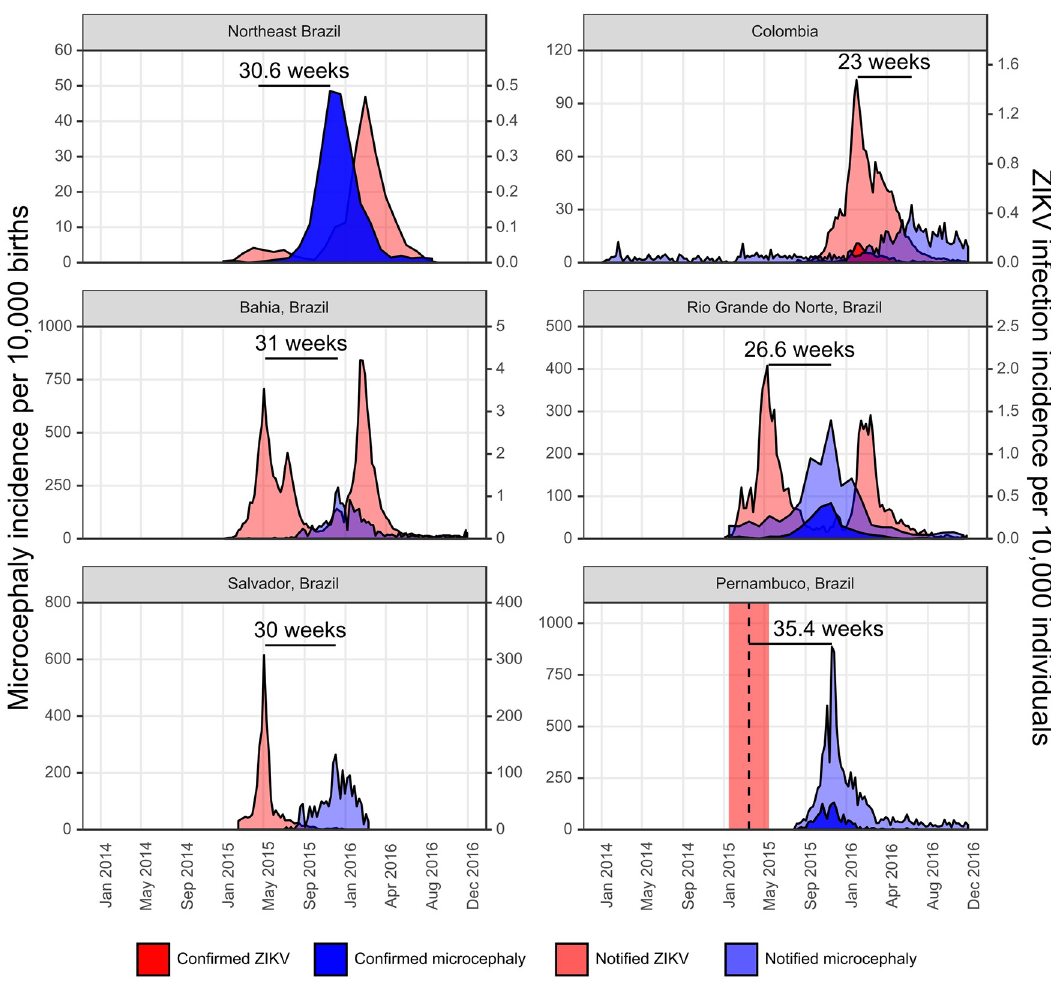
Fig 3. Notified and confirmed microcephaly and ZIKV infection incidence. X-axis shows date of report. Y-axis shows microcephaly incidence per 10,000 births (left) and ZIKV infection incidence per 10,000 individuals (right). Note different y-axis scales. ZIKV infection incidence for Northeast Brazil uses only reported cases in pregnant women with the entire population as the denominator. For Pernambuco, where comprehensive ZIKV infection incidence was not available, we show the peak epidemiological week from which incidence was reported (black dashed line) with a 4-month window (shaded red). Horizontal lines and labels show time in weeks between the initial peak of ZIKV infection incidence and peak microcephaly incidence. Confirmed and notified cases are distinguished by shading, where available. All incidence was reported by epidemiological week, apart from Northeast Brazil incidence and Rio Grande do Norte microcephaly incidence, which were reported by month. Note that no second y-axis is shown for Pernambuco, as no ZIKV infection incidence is